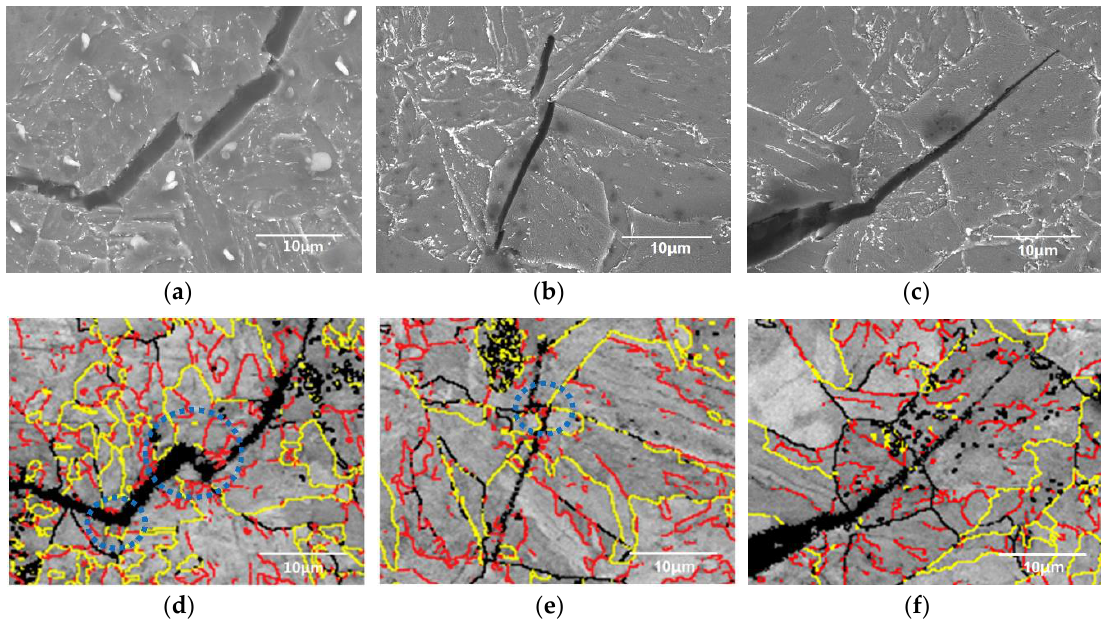
Figure 8. SEM ( a – c ) and boundary images ( d – f ) (red line: 2° < θ < 15°, black line: 15° < θ < 45°, yellow line: θ > 45°) of the secondary cracks observed on the fractured V-notch Charpy sample at −20 °C. ( a , d ) 0 t; ( b , e ) 1/4 t; ( c , f ) 1/2 t.